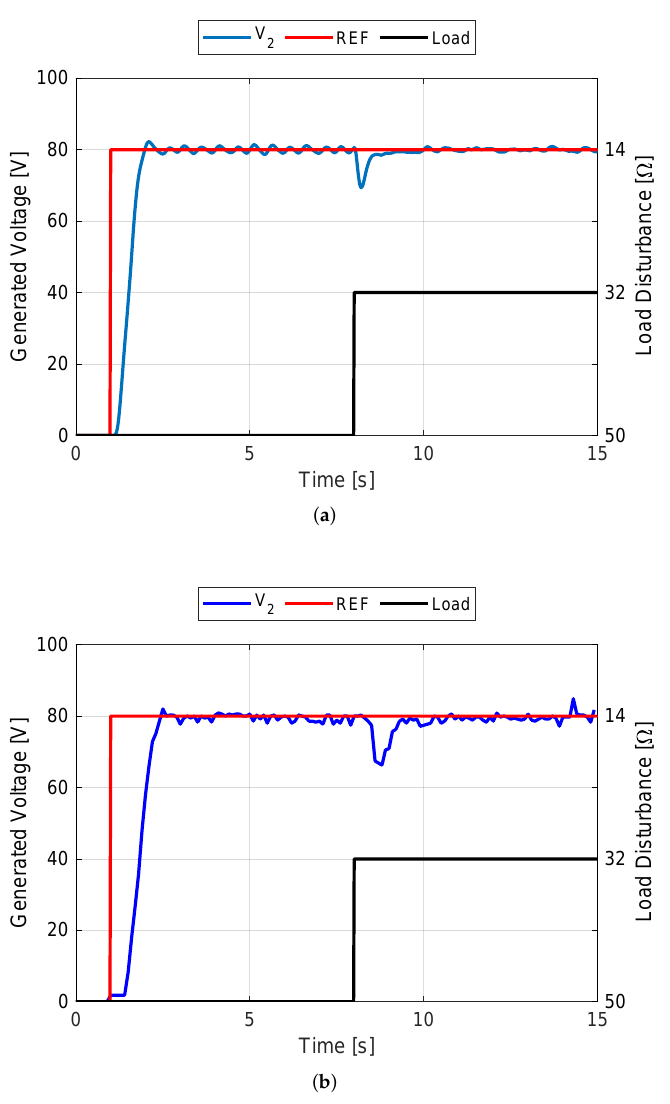
Figure 8. Voltage PID controller response using V 1 as manipulated variable (80 V reference): ( a ) Sim- ulation result and ( b ) experimental